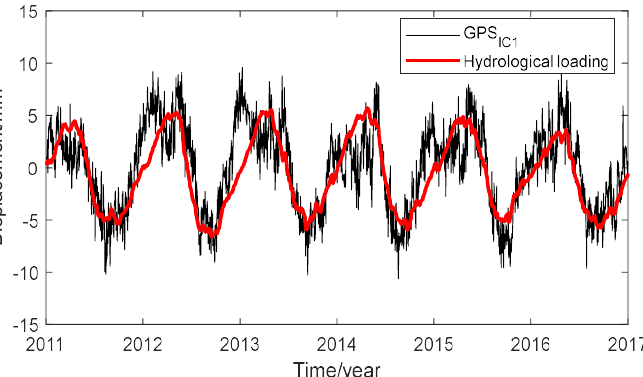
Figure 5. The comparison between modeled daily land water storage loading (LWS) displacement (http://massloading.net/, accessed on 16 November 2021) and GPS IC1 . For LWS, we use the